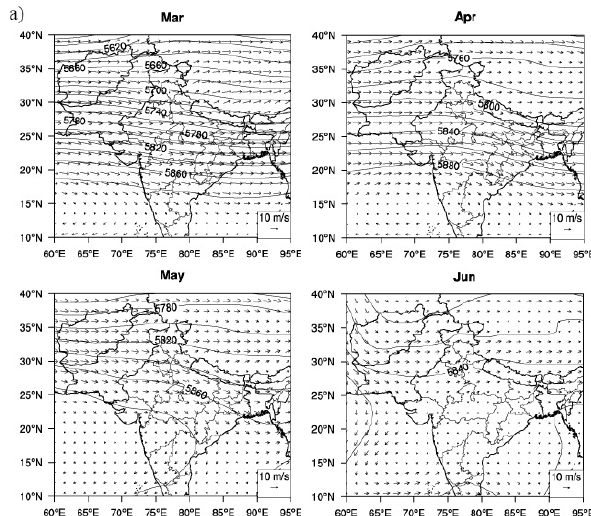
Fig. 2a. Mean geopotential height (m) and horizontal wind (m/s) Figure 2a) : Mean geopotential height (m) and horizontal wind (m/s) at 500 hPa from at 500hPa from 1998 to 2007 for the month of March, April, May 1998 to 2007 for the month of March, April, May and June. ERAInterim and June. ERAInterim (http://www.ecmwf.int/research/era/do/get/ era-interim) dataset were used for the above (http://www.ecmwf.int/research/era/do/get/era-interim ) dataset were used for the above analysis.